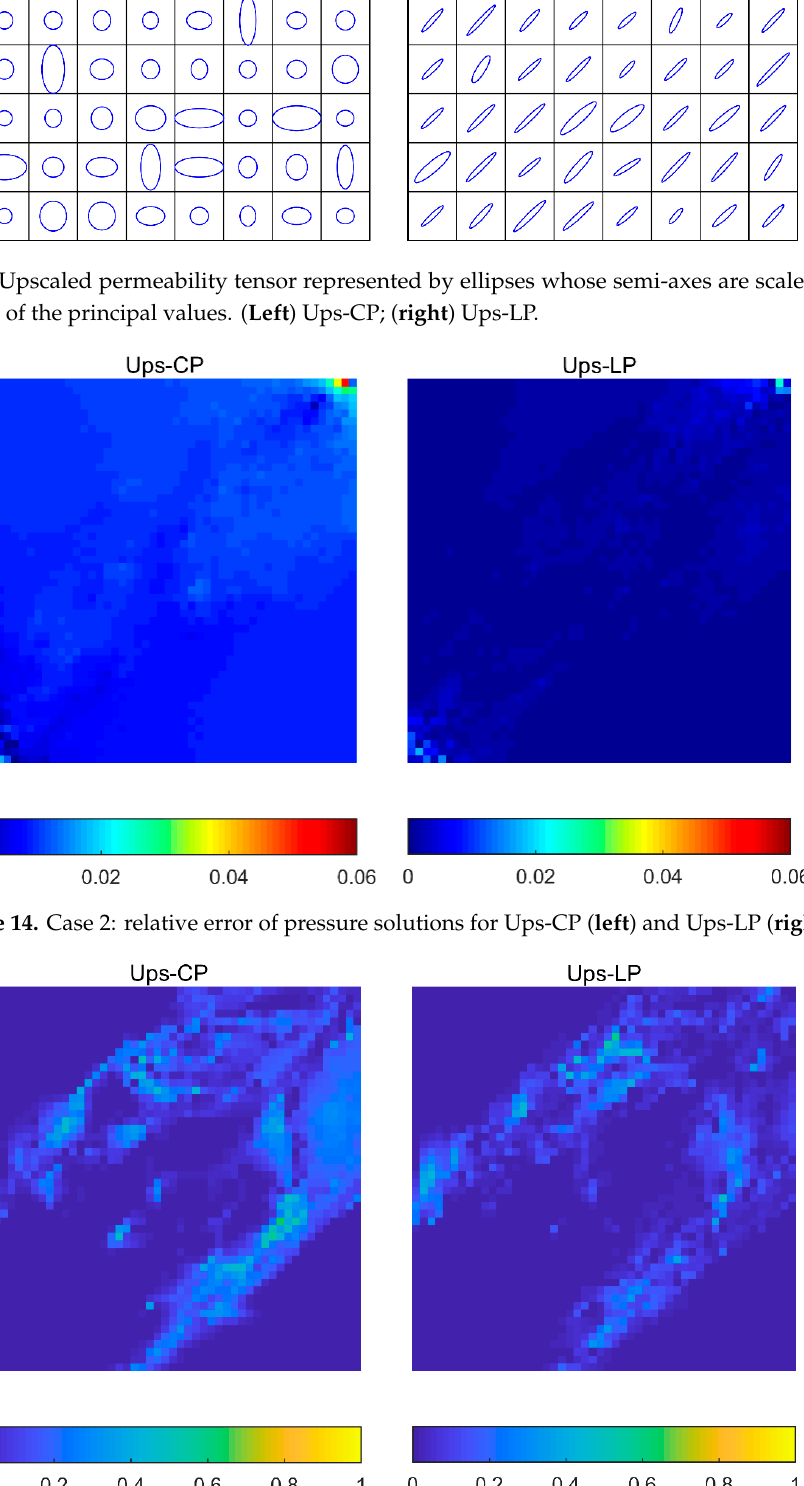
Figure 15. Case 2: absolute error of tracer concentration for Ups-CP ( left ) and Ups-LP ( right ).